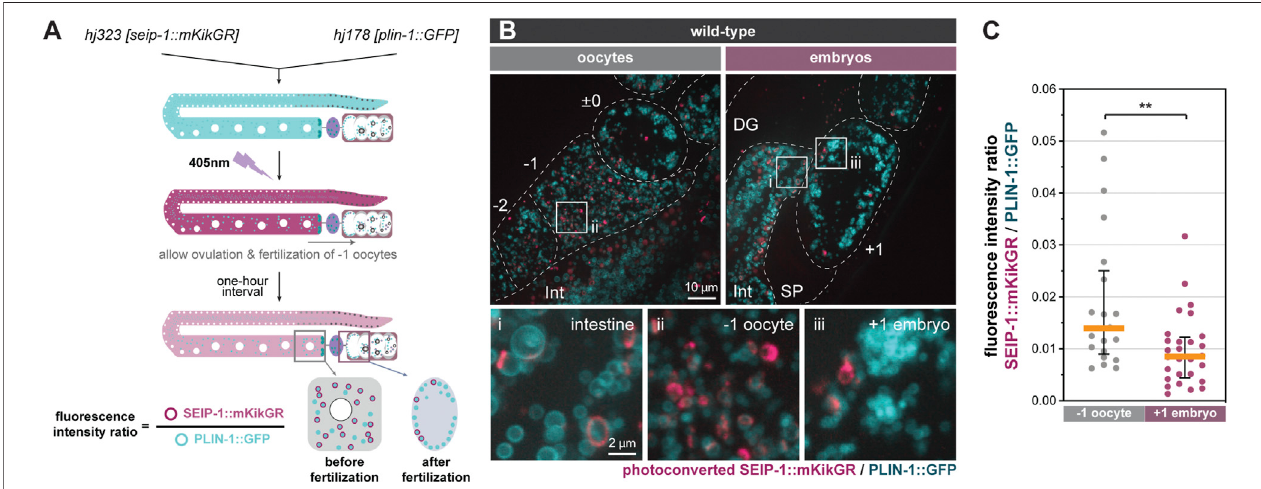
FIGURE 3 | Turnover of SEIP-1 after fertilization. (A) Schematic diagram of the experimental design for the labeling of pre-existing SEIP-1::mKikGR by photoconversion. The initial green (pseudocolored cyan) mKikGR can be photoconverted to red (pseudocolored magenta) by 405 nm illumination. The oocytes with photoconvertedSEIP-1::mKikGRwereallowedtobefertilizedina1-htimewindowpriortoimaging. (B) VisualizationofphotoconvertedredSEIP-1::mKikGR( hj323 )and PLIN-1::GFP ( hj178 ). Red mKikGR and GFP are pseudocolored magenta and cyan, respectively. Dotted lines mark the boundary between different tissues or embryos. Boxed regions were magni fi ed ×5 and displayed at the bottom. A projection of 4.5 μ m z stack reconstituted from 10 focal planes is shown. For anatomical positionsoftheROI,refer to Figure 2A . (C) Total fl uorescence intensityratiobetweenphotoconverted SEIP-1::mKikGRand PLIN-1::GFPinindividual 1-day-old adults. Number of animals analyzed: − 1 oocytes = 21; +1 embryos = 28. ** p < 0.01 (unpaired t